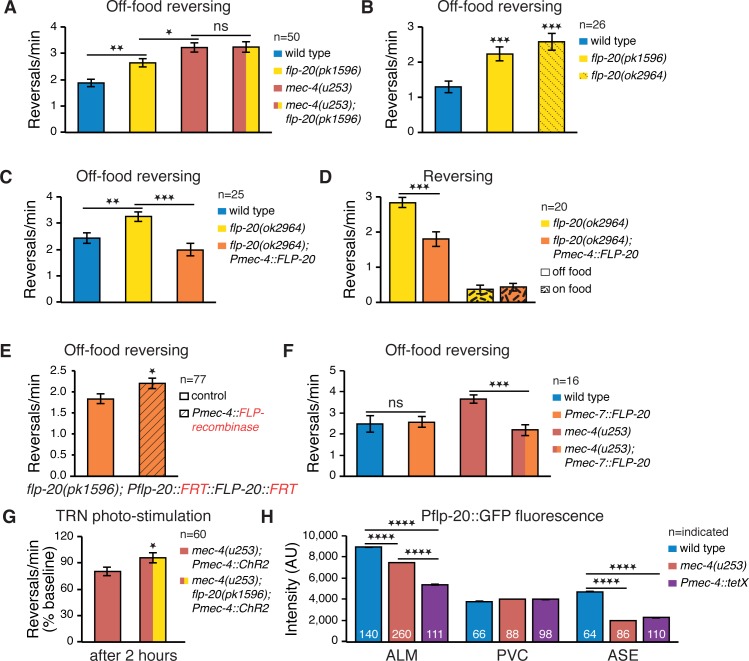
FLP-20 is involved in TRN neuropeptide signaling modulating locomotion.(A) flp-20 mutants have an increased off-food reversing rate that is smaller than the mec-4 increase. flp-20; mec-4 double mutants exhibit a similar increase in off-food reversing rate as mec-4 single mutants. (B) An additional flp-20 allele displays a similar increase in reversing frequency. (C) TRN-specific expression of FLP-20 cDNA restores flp-20 reversing rate off-food. (D) TRN-specific expression of FLP-20 cDNA reduces flp-20 reversing rate off-food, but not on-food (2-way ANOVA interaction p = 0.0005). (E) Eliminating functional FLP-20 sequence exclusively in the TRNs is sufficient for increasing reversing rate. (F) Overexpression of FLP-20 in the TRNs of mec-4(253) mutants decreases their reversing rate. (G) TRN photo-stimulation has a weakened suppressive effect on the reversing rate of Mec-deficient worms lacking functional FLP-20. (H) Pflp-20::GFP fluorescence intensity, indicating FLP-20 transcription, in mec-4(u253) mutants and following disruption of exocytosis in the TRNs is reduced in ALM, does not substantially vary in PVC, and is also reduced in the ASE neurons (2-way ANOVA interaction p < 0.0001). Sample size indicated in each panel; Error bars represent SEMs; *p < 0.05, **p < 0.01, ***p < 0.001, ****p < 0.0001 t test with Bonferroni corrections for multiple comparisons where relevant.